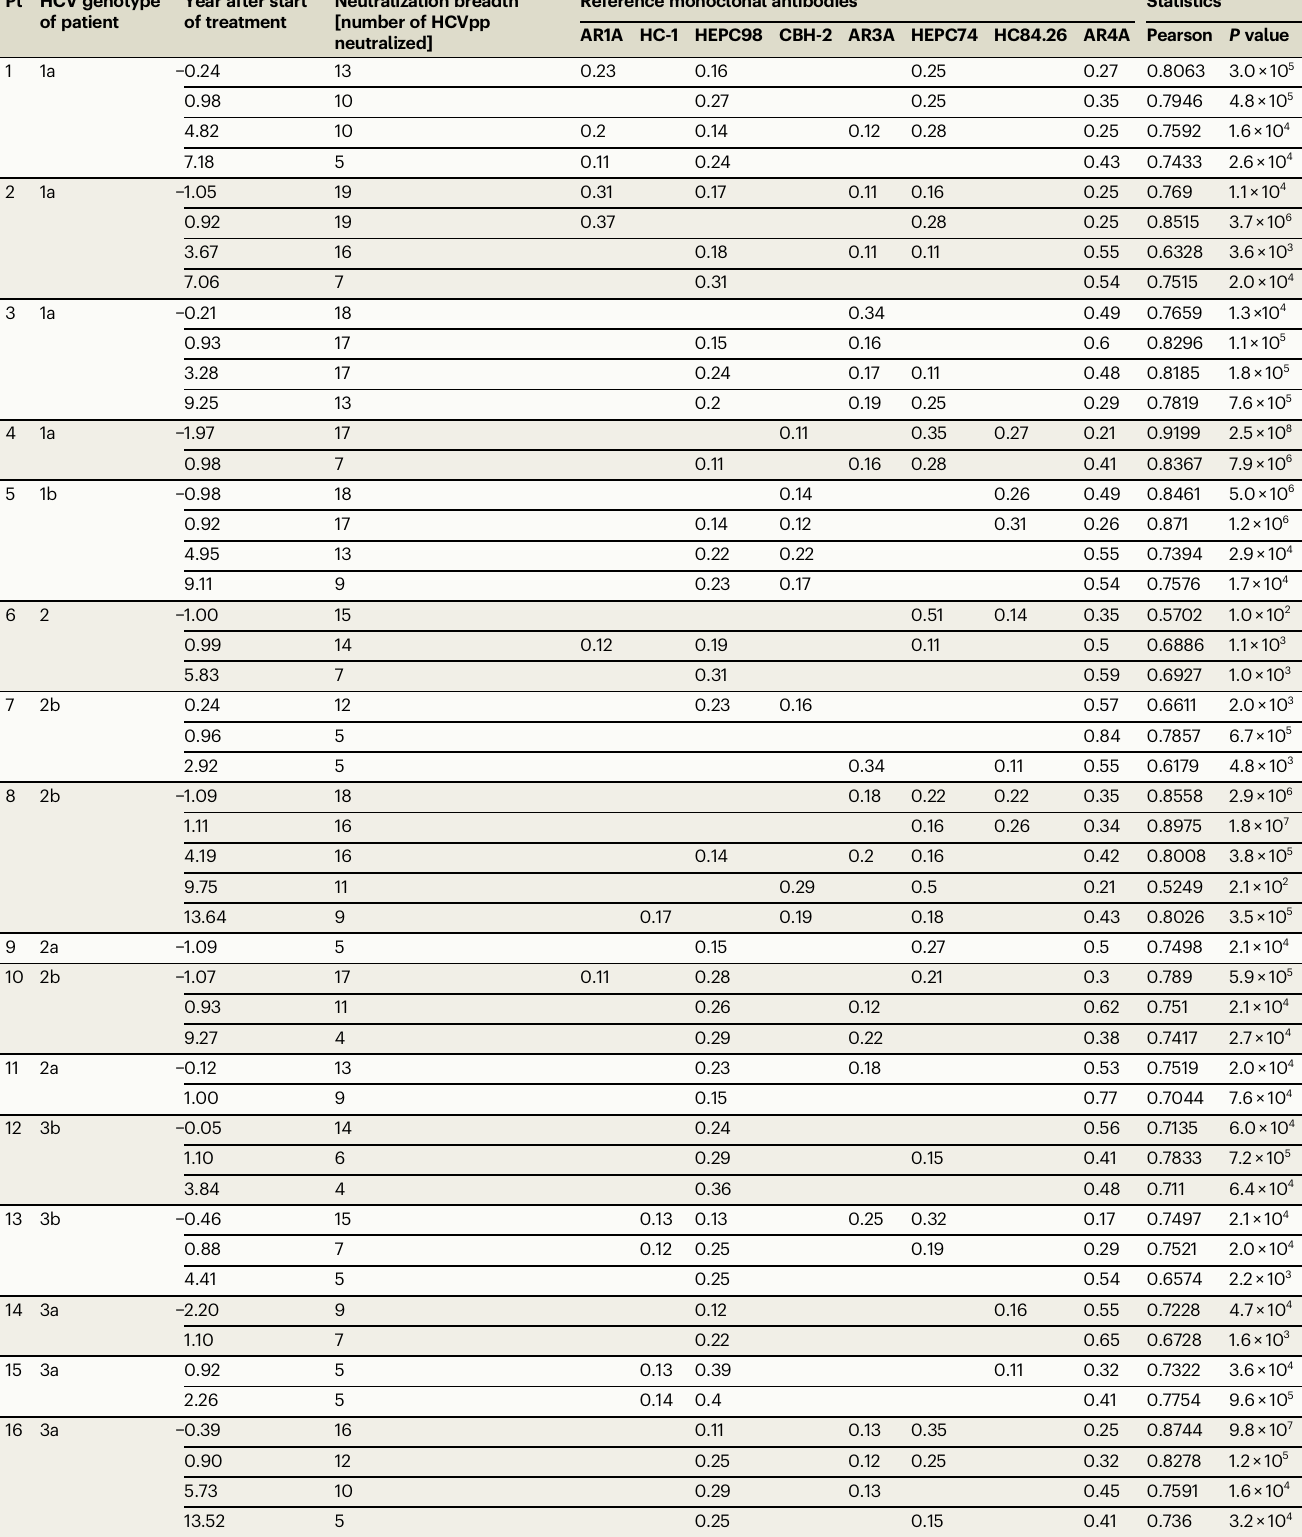
Table 2 | Deconvolution of NAbs in serum of patients after interferon-based treatment and clearance of chronic HCV infection Pt HCV genotype of